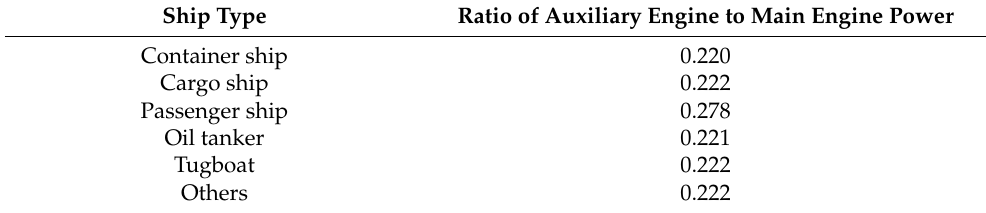
Table 6. Power ratio of auxiliary engine and main engine for each ship type.